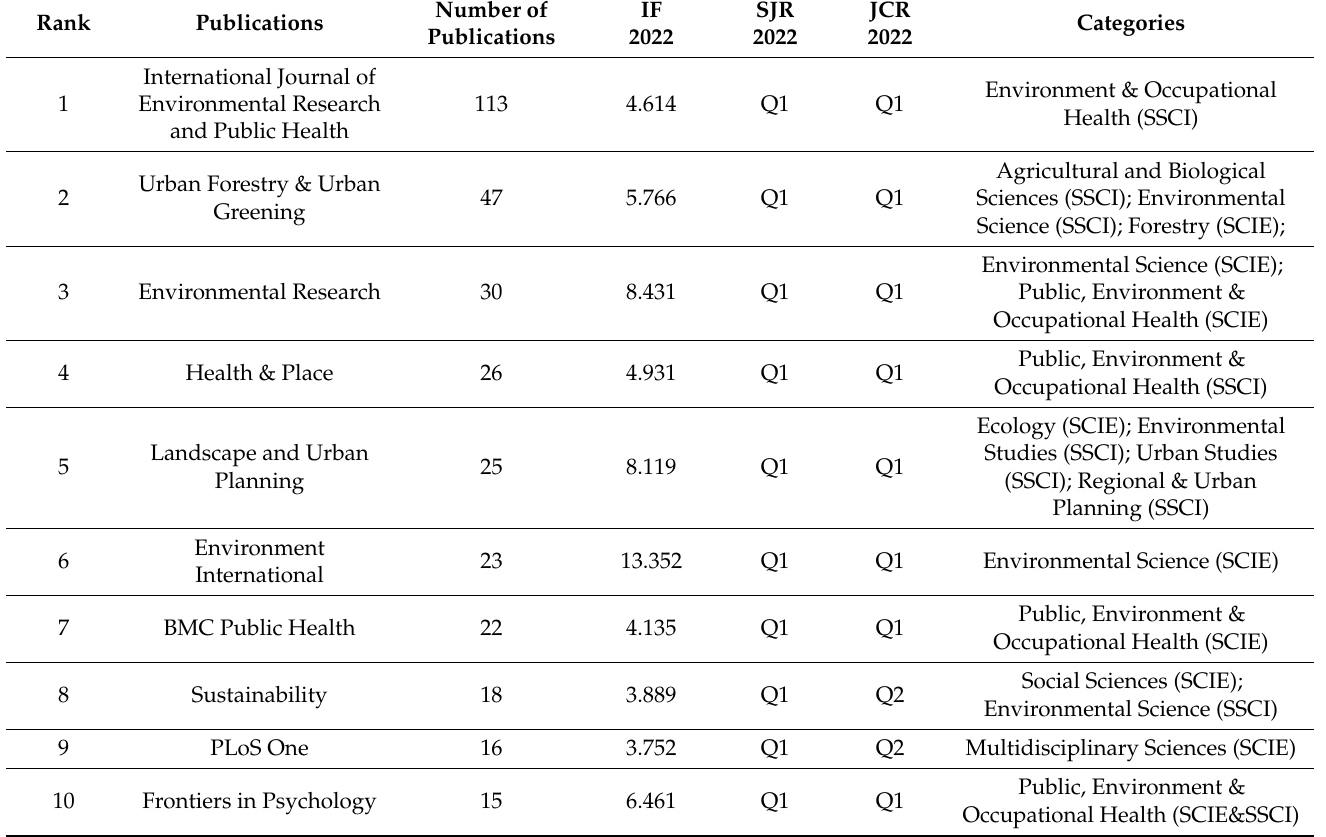
Table 4. Top 10 journals for the study of green space and senior mental